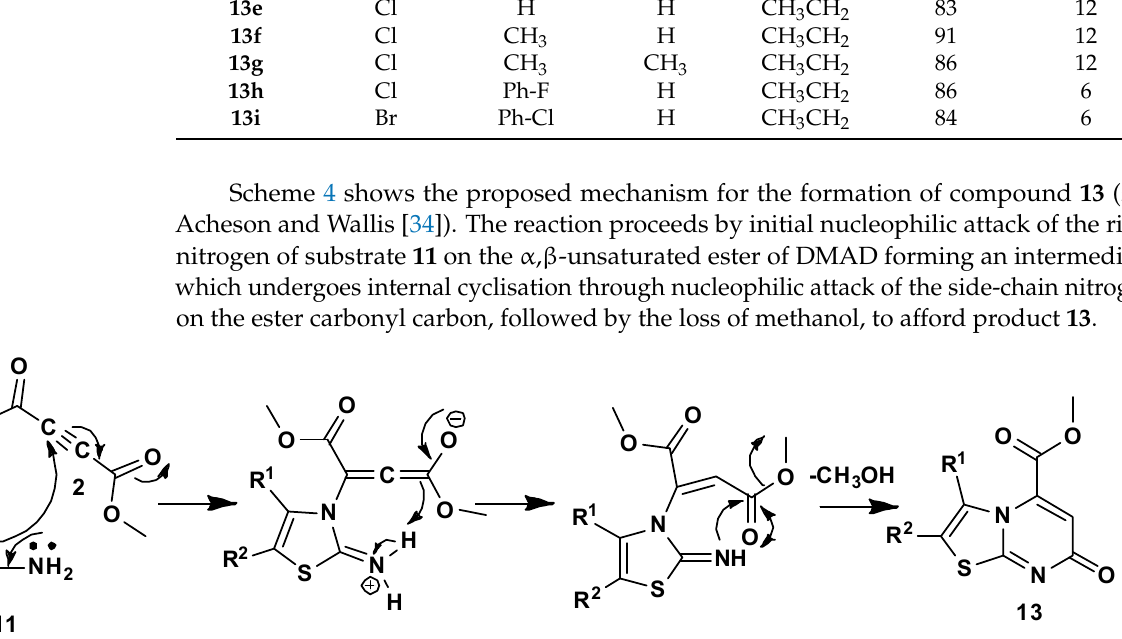
Scheme 4. Proposed reaction mechanism for the formation of compounds 13a–j